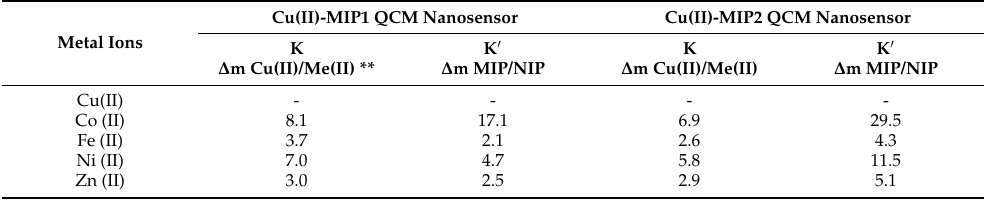
Table 5. The selectivity (K) and imprinting efficiency (K (cid:48) ) values of the Cu(II)-MIP nanoparticles. Metal Ions